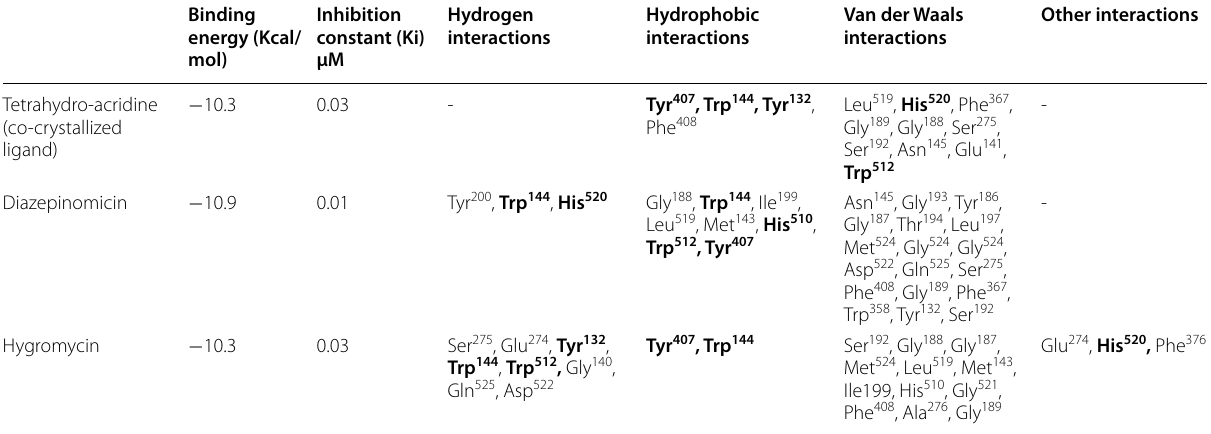
Table 1 Docking result of the top two ligands within the active site of the modeled A. pisum ’s AChE Binding energy